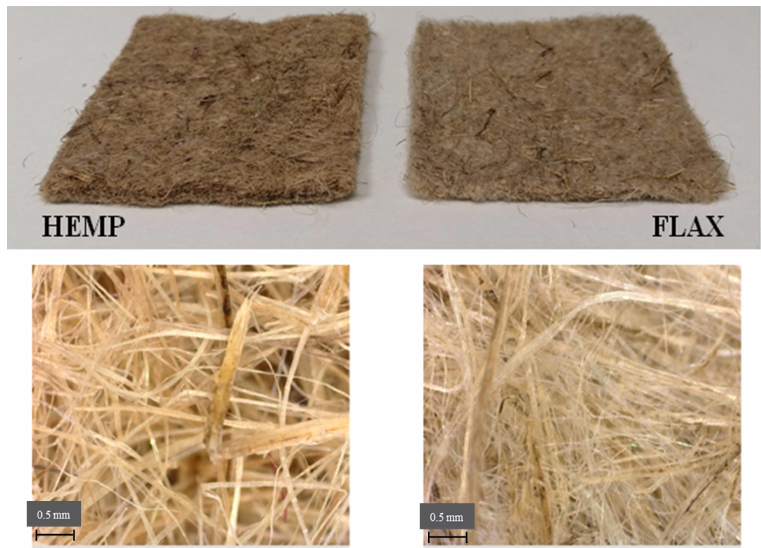
Figure 1. Hemp- and flax-based felts (below: optical microscopy images of the felt